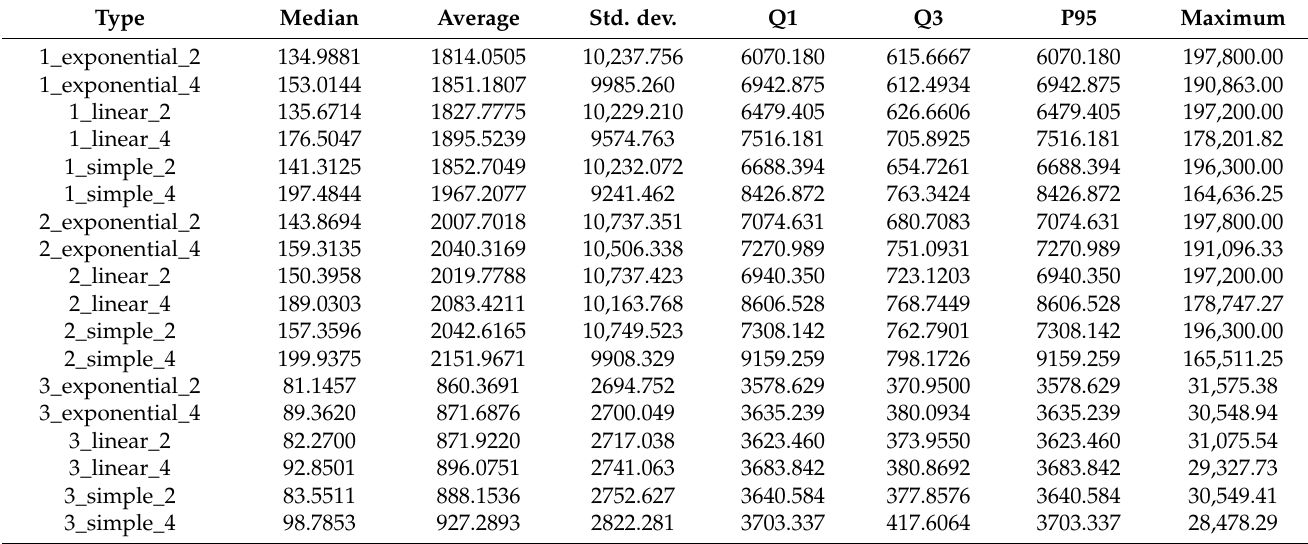
Table 7. MAE statistics for the third set of missing data (3—from the set).